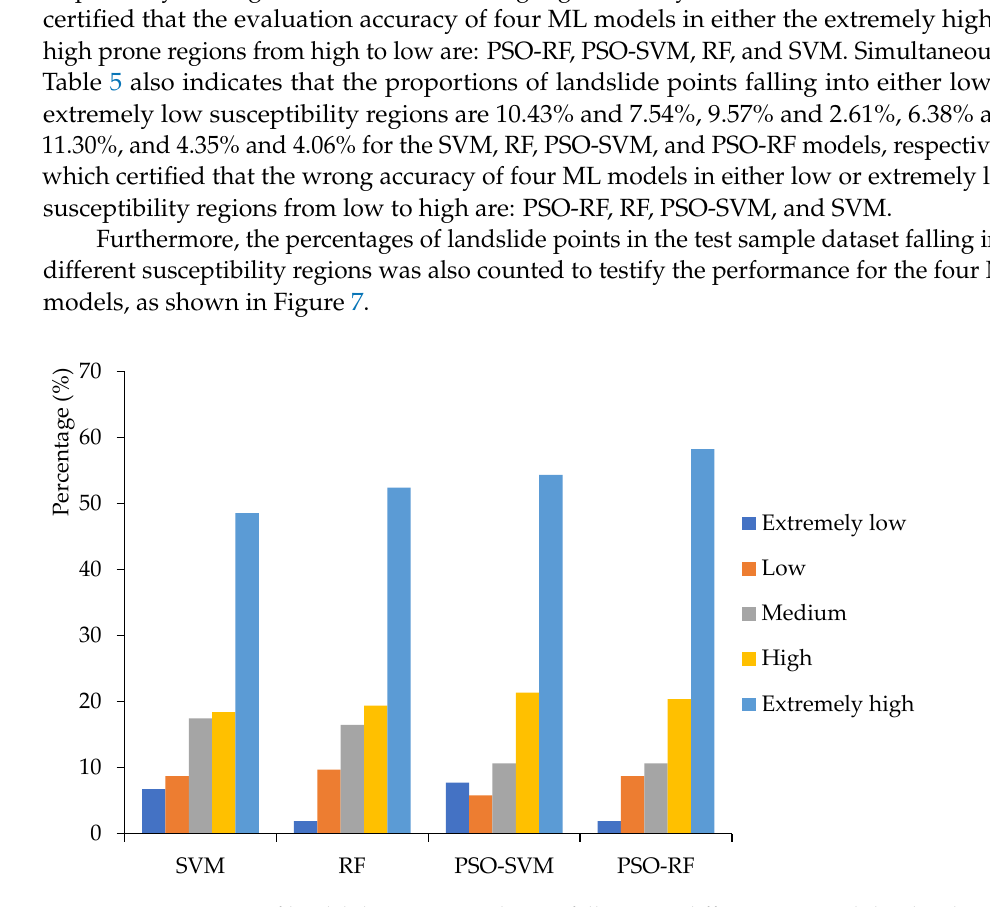
Figure 7. Percentages of landslides in testing dataset falling into different susceptibility levels.